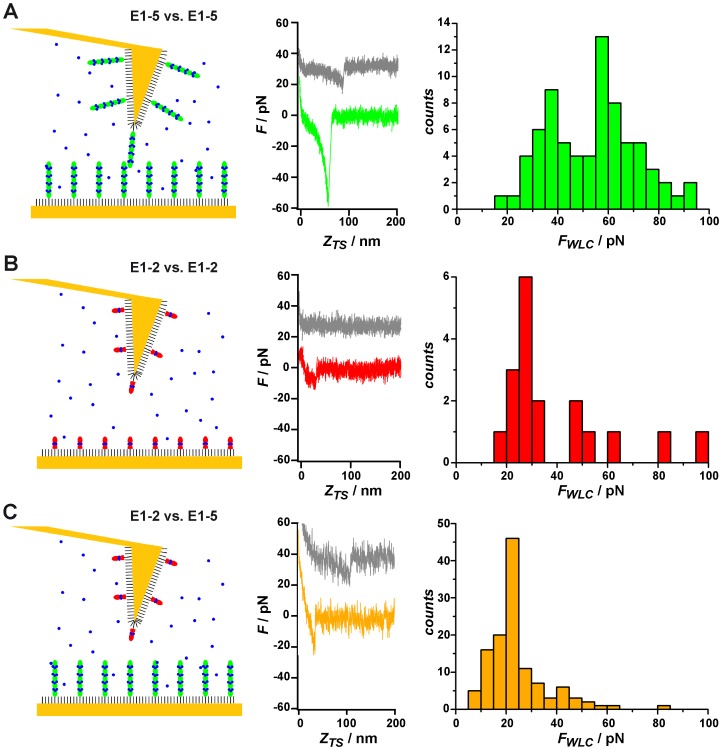
Single-molecule force spectroscopy.(A) Force spectroscopy data obtained during the bond rupture between E1-5 constructs attached to a gold-coated AFM tip and a gold-covered glass slide (see scheme). A typical force extension curve shows the unbinding of E1-5 dimers in the absence of calcium ions (grey) and the presence of calcium ions (green). The extension curves show nonlinear stretching behavior preceding bond rupture. The rupture force histogram (green) reveals two major maxima potentially corresponding to two types of bonds. (B) Corresponding SMFS data of force-assisted unbinding of E1-2/E1-2 (red) or (C) E1-5/E1-2 (orange) cadherin molecules attached to tip and substrate as illustrated in the schemes. Tip substrate contact time was 0.1 s and pulling velocity was 1 μm/s.